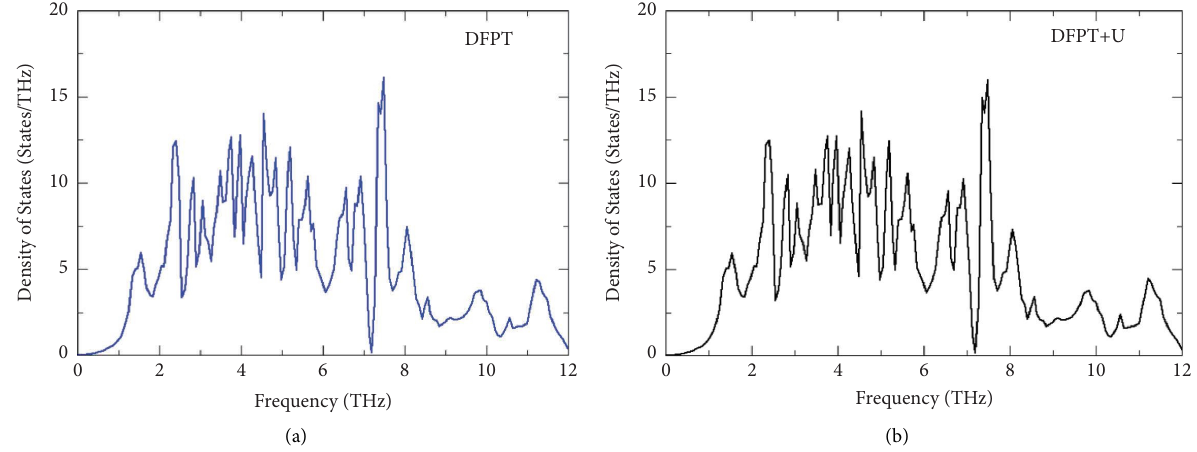
Figure 6: Phonon density of states of CaHfS